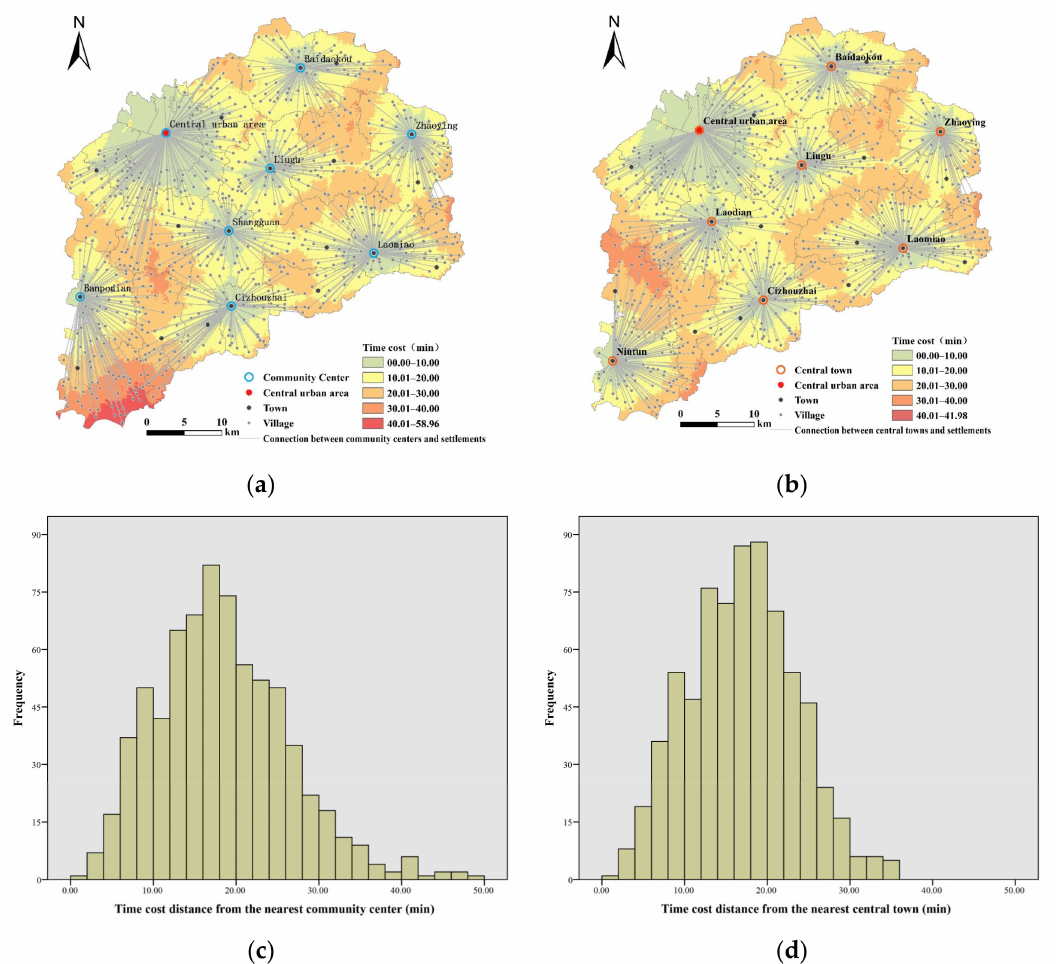
Figure 7. Distribution of indicators related to the spatial coverage of central towns: ( a ) Spatial distribution of the time cost distance from the nearest community center; ( b ) Spatial distribution of the time cost distance from the nearest central town; ( c ) Frequency distribution of the time cost distance from the nearest community center; ( d ) Frequency distribution of the time cost distance from the nearest central